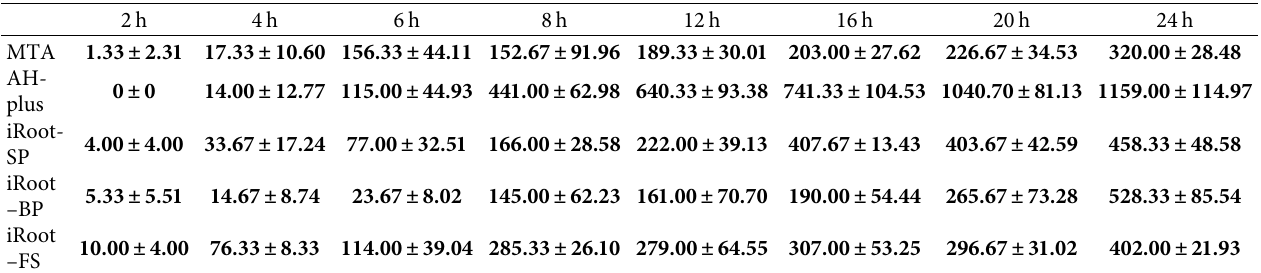
Table 8: Porphyromonas gingivalis group (electron microscopy counting).